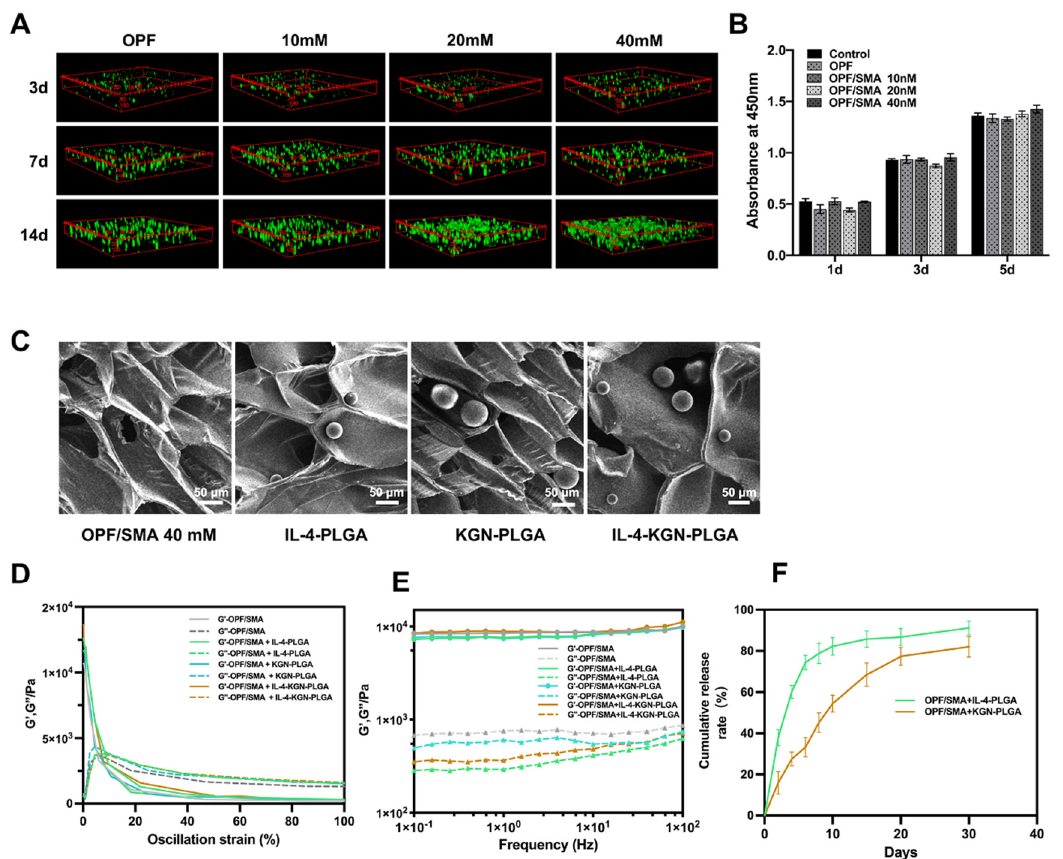
Figure 3. Cell proliferation and cell viability staining experiment. ( A ) 3D cell culture. The cell viability was detected by Calcein-AM/PI double staining kit. Fluorescence photos were taken by laser confocal microscope. ( B ) Cytotoxicity test and cck8 kit detection. After incubation for 1 day, 3 days, and 5 days, the cell proliferation was detected by CCK8 kit. ( C ) Scanning electron microscope (SEM) imaging of hydrogel loaded with IL-4-PLGA microspheres and KGN-PLGA microspheres. ( D ) Dynamic modulus of OPF/SMA, OPF/SMA+IL-4-PLGA, OPF/SMA+KGN-PLGA, and OPF/SMA+IL-4-KGN-PLGA at varying stains from 0.1% to 100%. ( E ) Dynamic modulus of OPF/SMA, OPF/SMA+IL-4-PLGA, OPF/SMA+KGN-PLGA, and OPF/SMA+IL-4-KGN-PLGA at varying angular frequencies from 0.1 to 100 Hz. ( F ) In vitro sustained release of OPF/SMA+IL-4-PLGA and